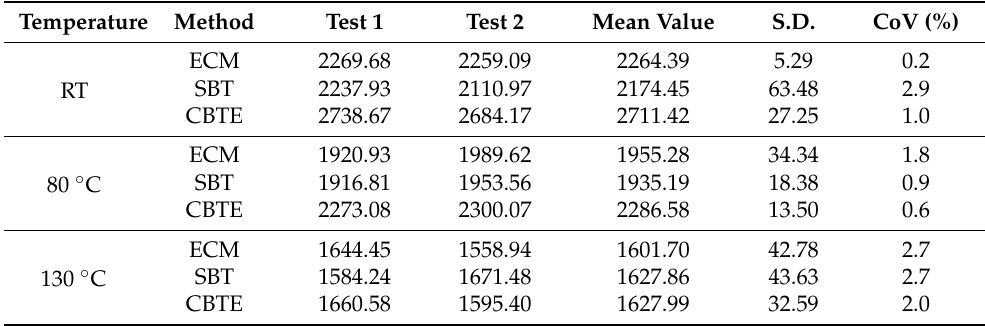
Table 2. Mode II fracture toughness of ENF specimens evaluated at different temperatures. (Unit: J/m 2